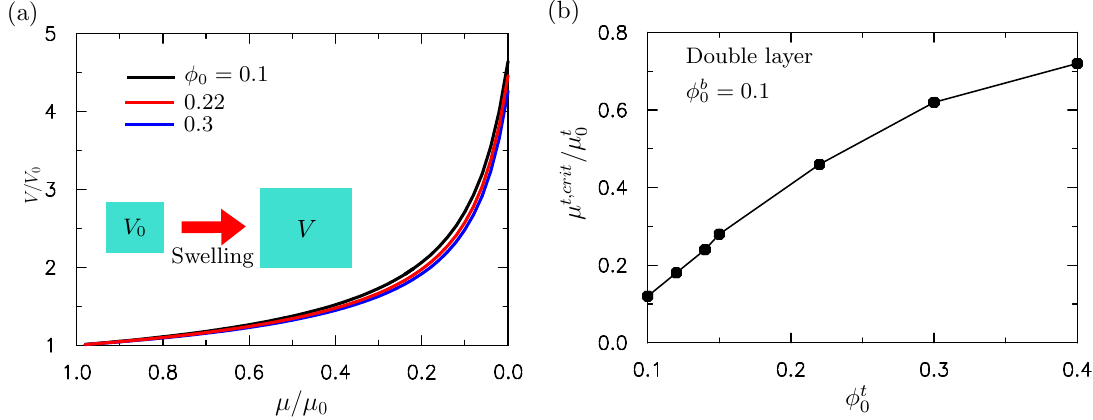
Figure 5. ( a ) Volume expansion V / V 0 vs µ / µ 0 predicted by the proposed constitutive model for hydrogels. The decrease in µ / µ 0 led to the volume expansion of hydrogels. ( b ) The critical volume expansion ( µ t , crit / µ t ) at which the surface instability occurred as a function of the initial volume 0 fraction of the polymer chain φ t . The initial volume fraction of the polymer chain of the lower layer 0 = 0.1. The surface instability was purely induced by the absorption of water in the was fixed as φ b 0 upper